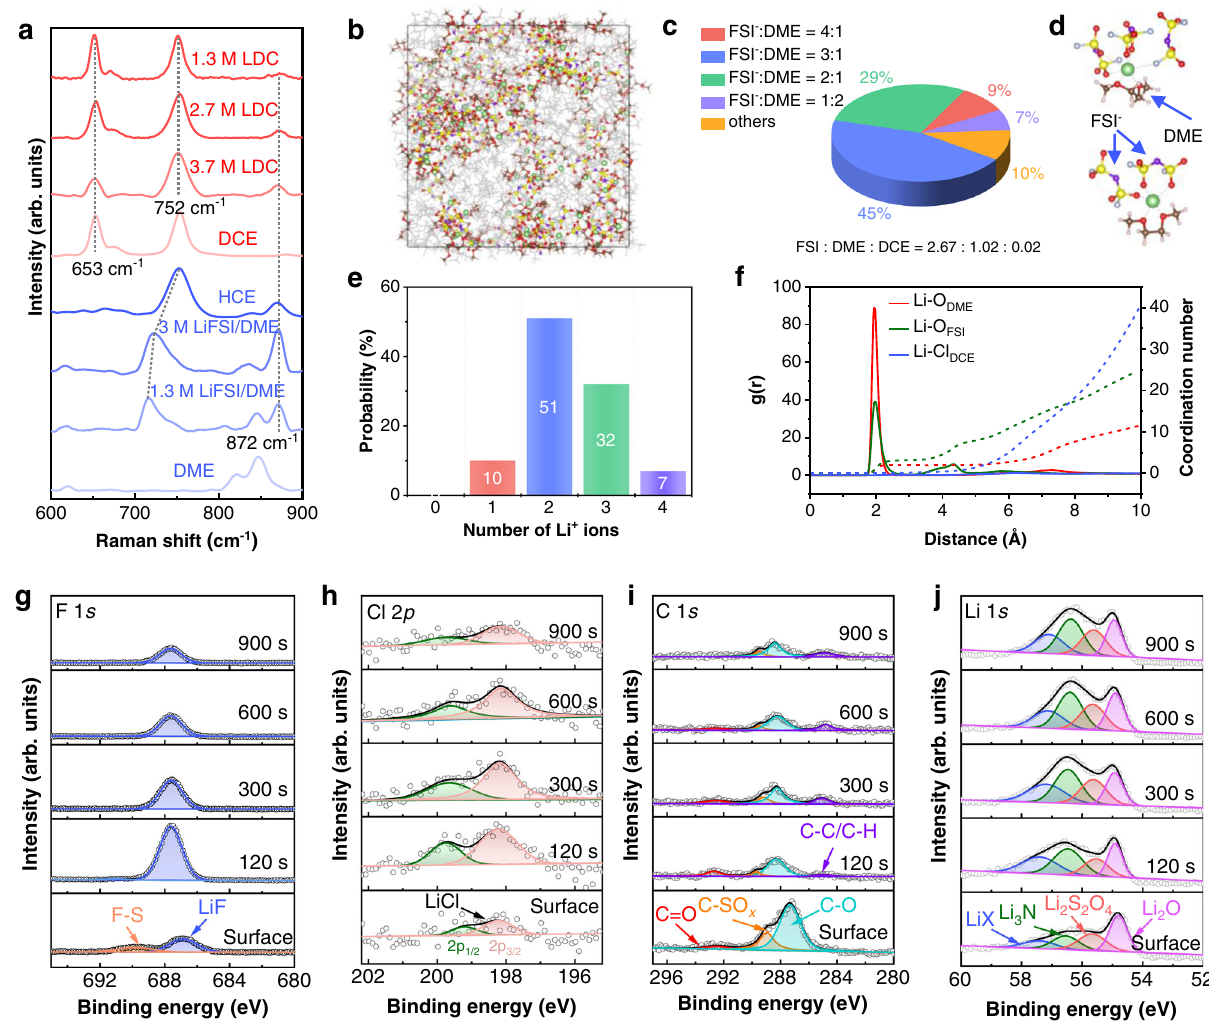
Fig.3|AnalysisofLi + solvationstructuresandSEIcomponents.a Ramanspectra of the solvents and electrolytes. b Simulated structures of 1.3M LDC electrolyte. c ProportionofFSI − /DMEwithdifferentratiosin1.3MLDCelectrolyte. d TypicalLi + solvationstructureswithFSI − /DMEratioof3/1and2/1. e NumberofadjacentLi + ions